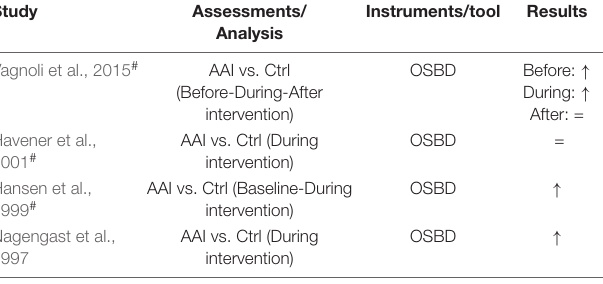
TABLE 5A | Effect of AAI on stress and pain (physiological outcomes) (controlled studies).